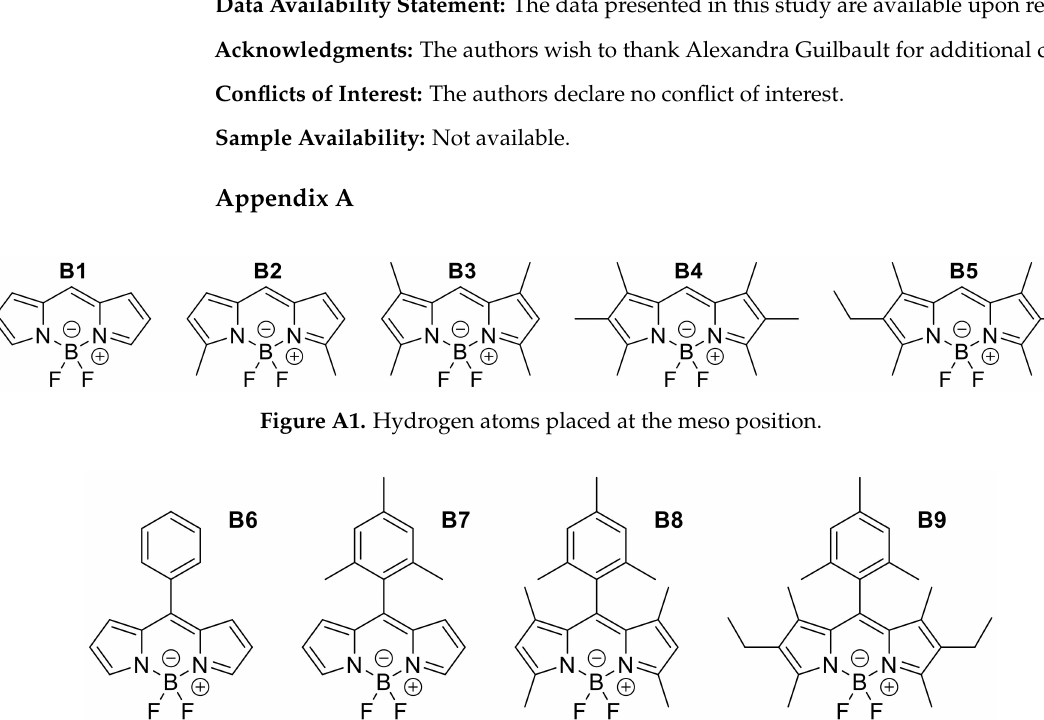
Figure A2. Aromatic groups placed at the meso